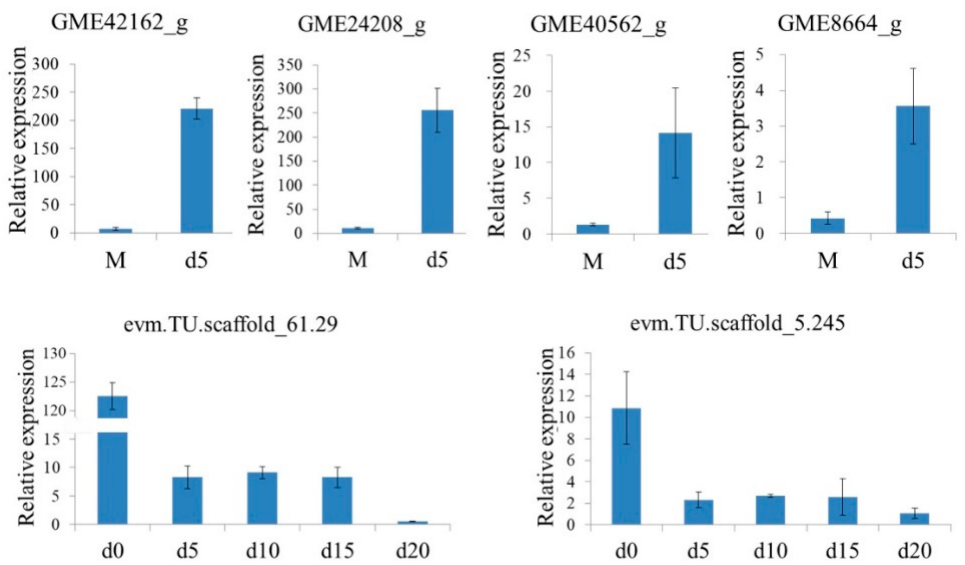
Figure 6. The RT-qPCR analysis of two upregulated peroxidase (POD) genes (GME42162_g and GME24208_g) and two upregulated laccase genes (GME40562_g and GME8664_g) in Mycena sp. WM and two downregulated abscisic acid (ABA)-related genes (NCED-2, evm.TU.scscaffold_5.245 and PYL12-like, evm.TU.scaffold_61.29) at different time points (beginning, d0; 5th day, d5; 10th day, d10; 15th day, d15; 20th day, d20) of their coculture. Bars represent the standard error of the mean, SE (n = 9).